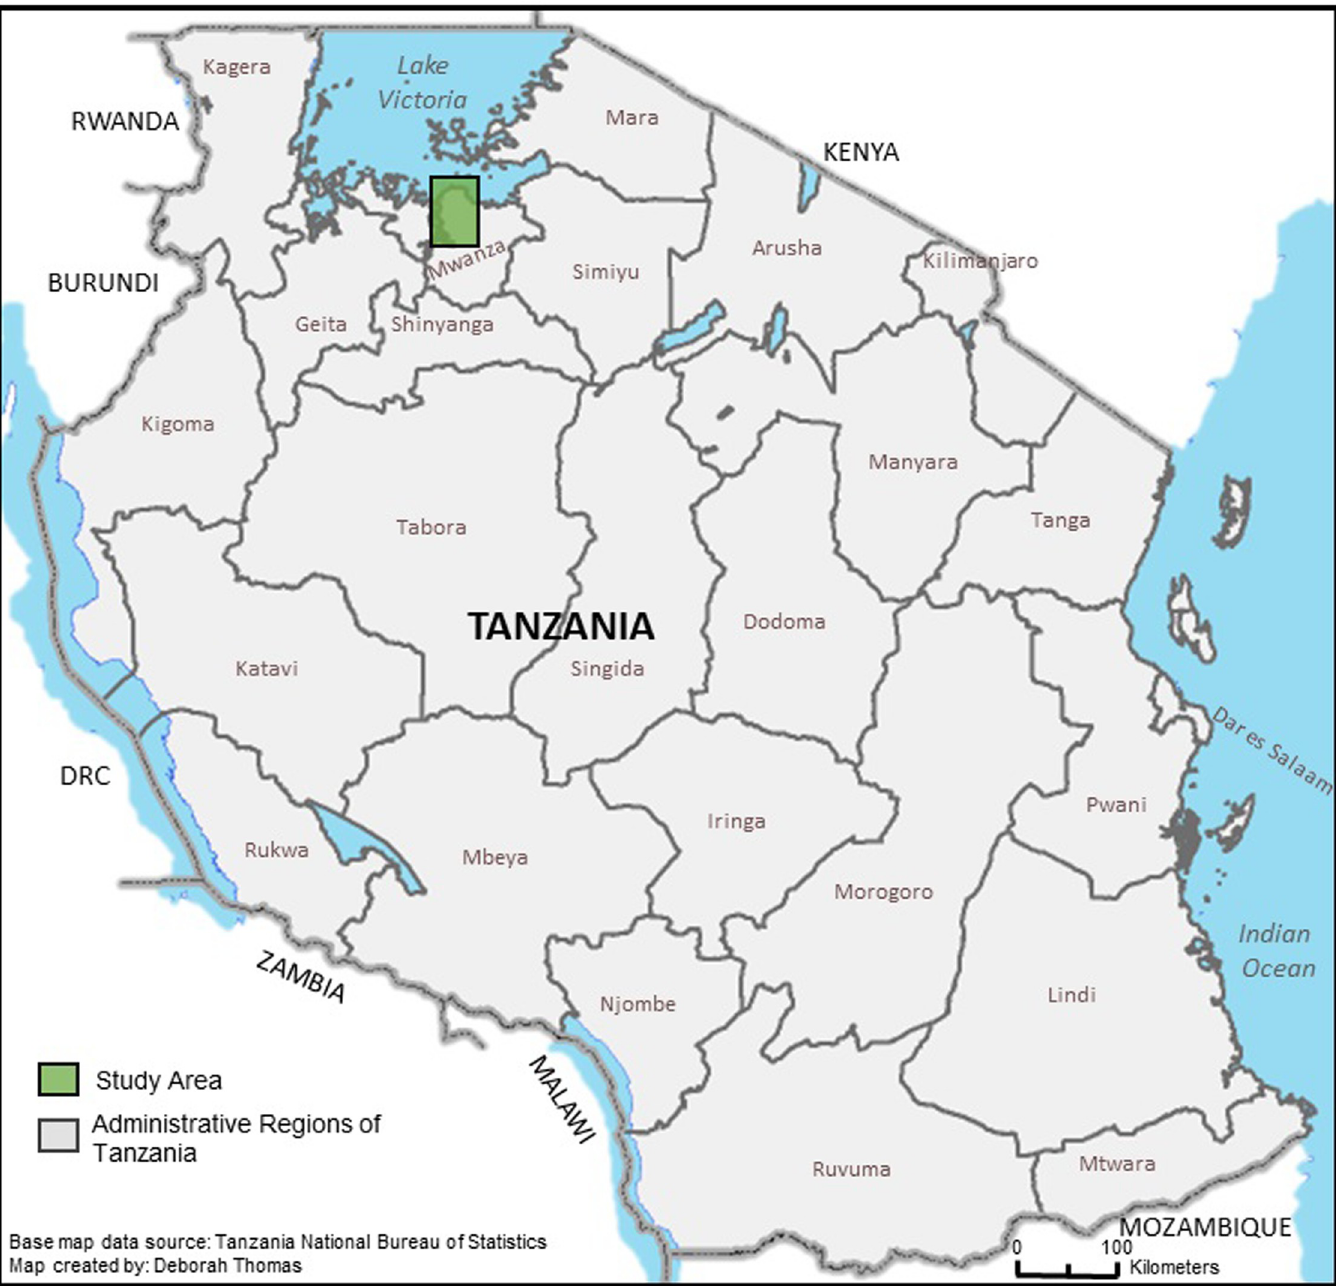
Fig 1. Study area, Mwanza City, Tanzania. Base map data source: OCHA, https://data.humdata.org/dataset/cod-ab-tza. Map created by: Deborah Thomas.